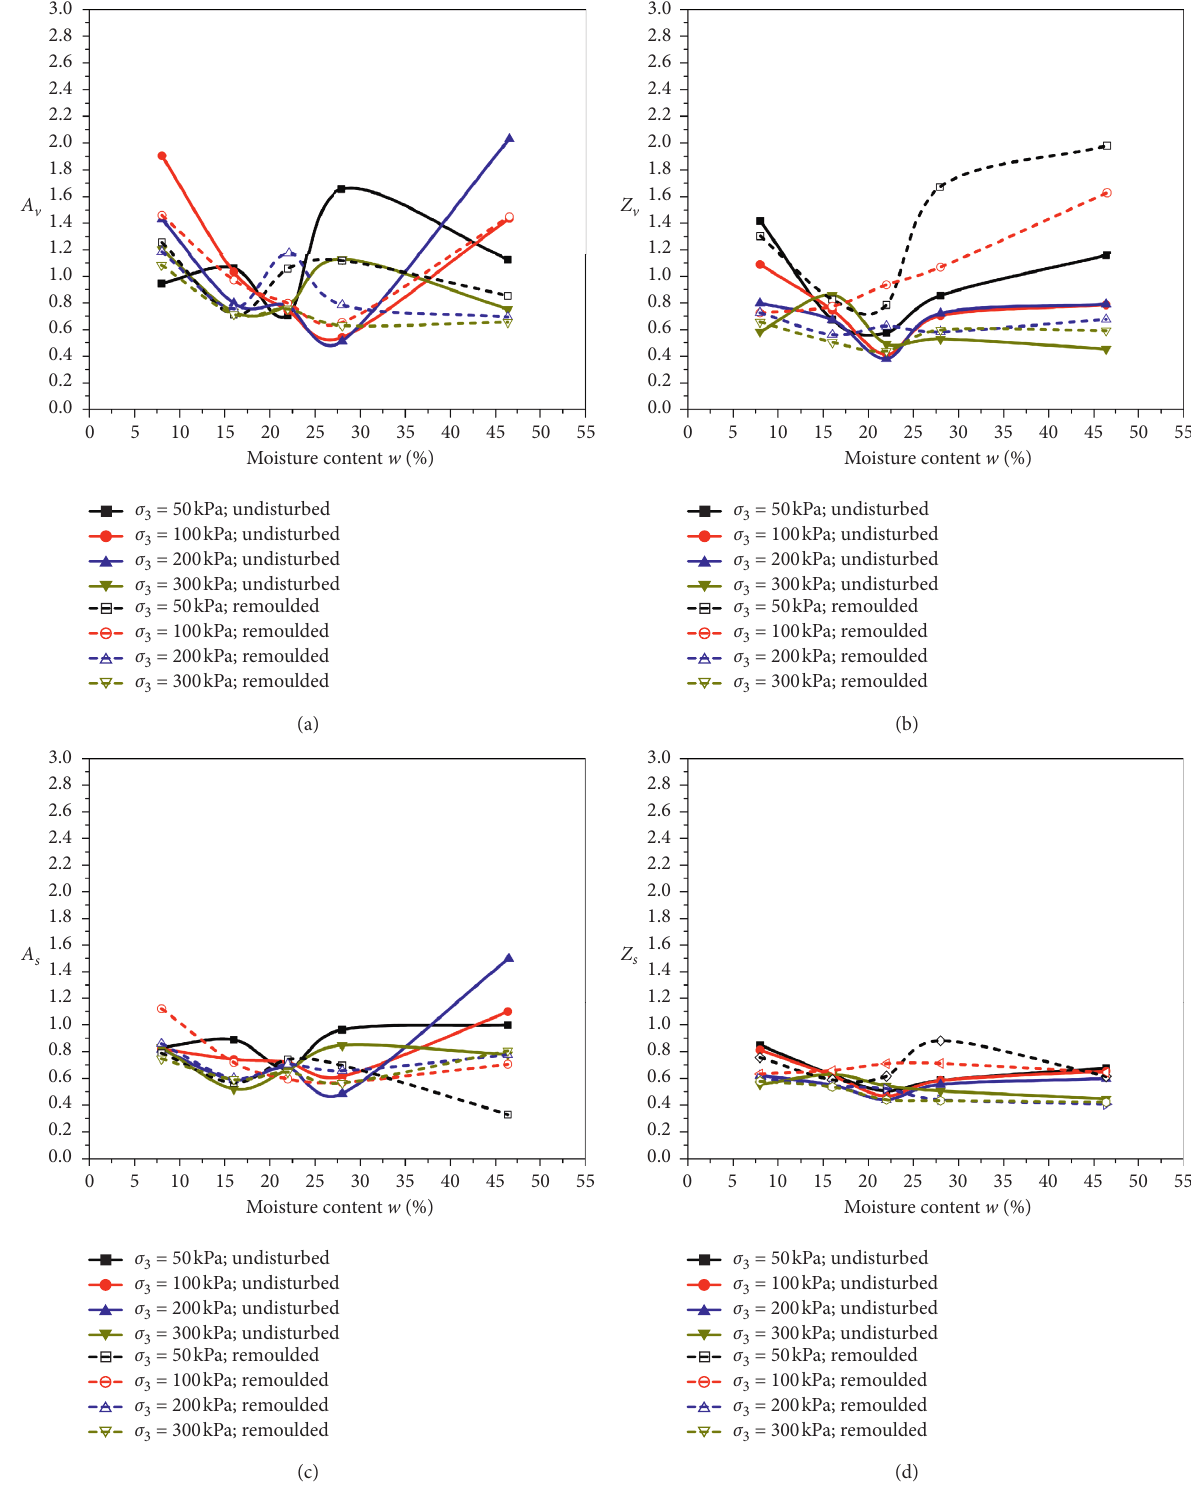
Figure 8: Effects of confining pressure and moisture content on parameters of double-parameter disturbance function for undisturbed and remoulded soil samples (a) A v ; (b) Z v ; (c) A s ; (d) Z s